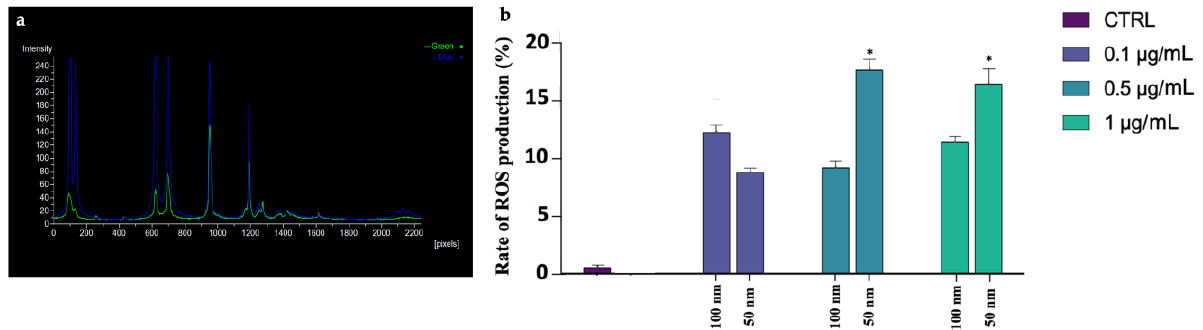
Figure 7. ( a ) Analysis of fluorescence intensity of each spermatozoon. Blue peaks indicate the intensity of Hoechst 33342 that is specific for the nucleus, while green peaks show spermatozoa positive to the DCFH2-DA probe; ( b ) mean percentage of spermatozoa positive of oxidative stress after the exposure (30 min) to 50 and 100 nm PS-NPs increasing concentrations. Approximately 400 spermatozoa were counted in five different fields for each sample. In addition, two replicates were performed, in a total of 8 samples and 3200 spermatozoa analyzed. Significant data were obtained at the two higher concentration (0.5 µg/mL and 1 µg/mL) for 50 nm PS-NPs (* p < 0.05).